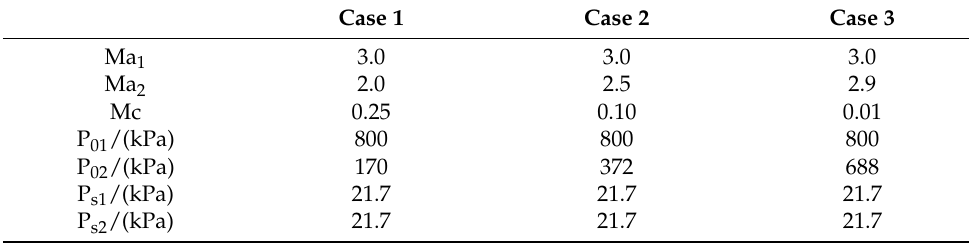
Table 1. Design parameters of the wind